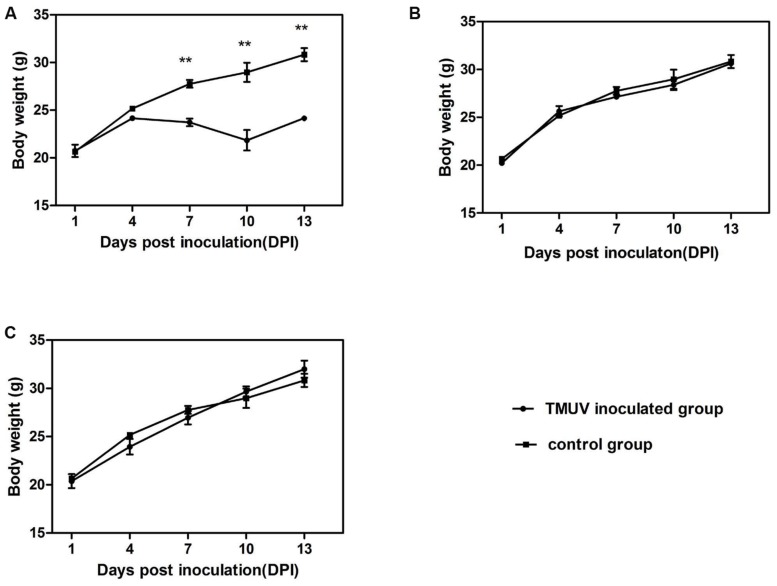
Comparison of body weight changes for mice inoculated with TMUV by different routes. The i.c. group mice (A), the i.a. group mice (B), the i.h. group mice (C) were inoculated with 50 μL × 104.8 ELD50/0.2mL of the challenge virus. Bars denote means ± standard deviation (SD). The mean value was statistically significant, calculated by the two-tailed Student’s unpaired t-test (∗∗P < 0.01).